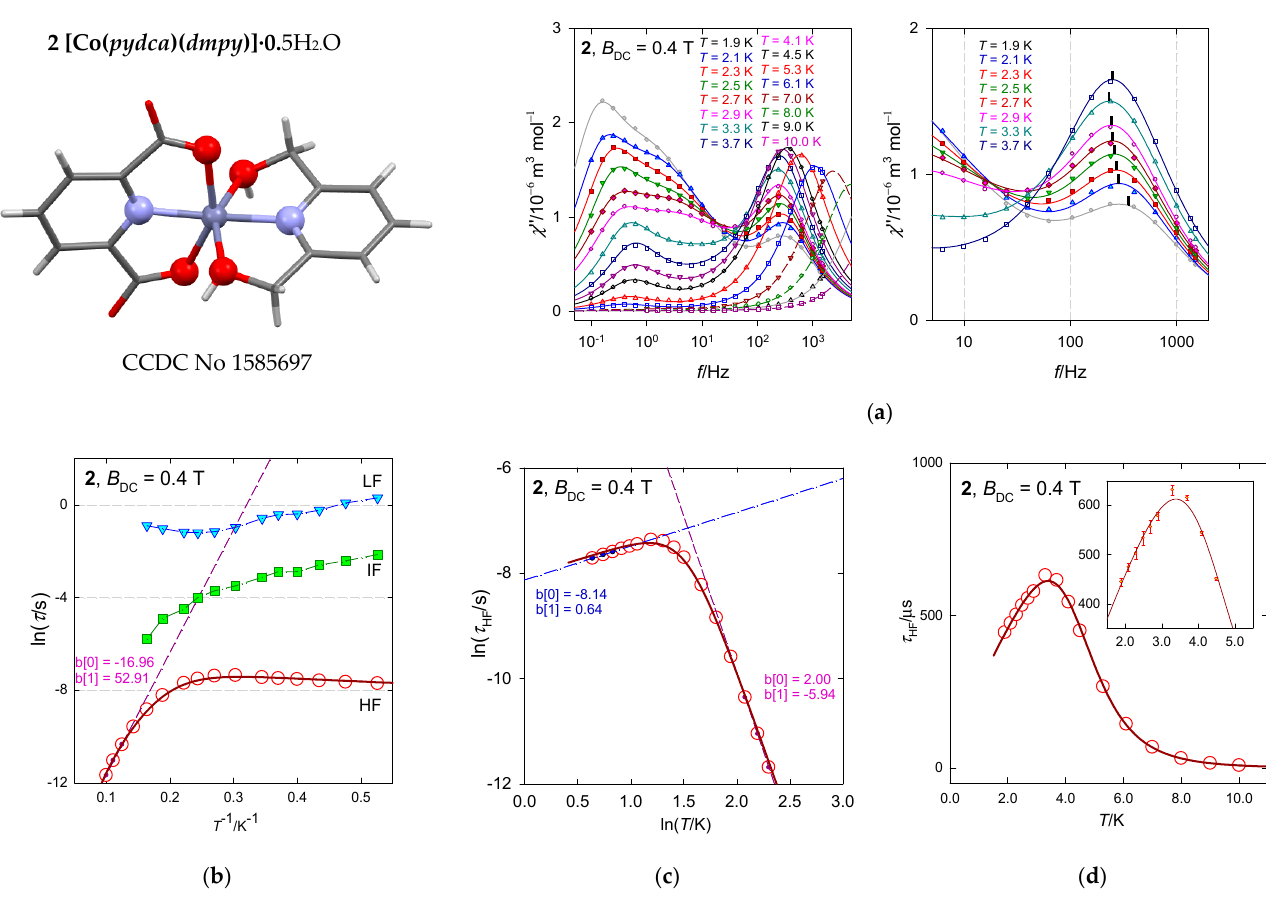
Figure 9. AC susceptibility and relaxation time for 2 . Solid lines—fitted. ( a )–field dependence, ( b ) frequency depenence, ( c )–relaxation time vs field.